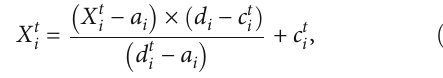
Figure 2: The simpli fi ed CAD